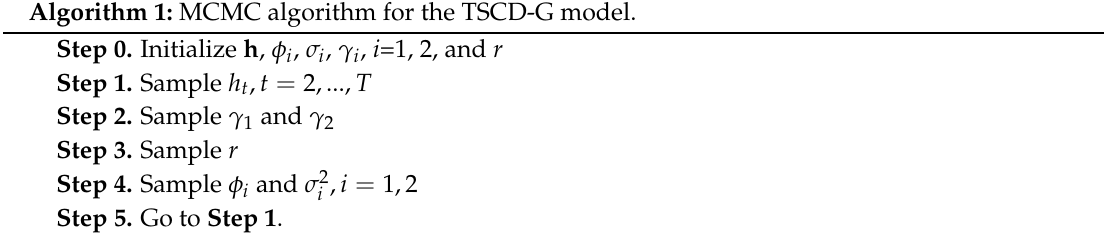
Algorithm 1: MCMC algorithm for the TSCD-G